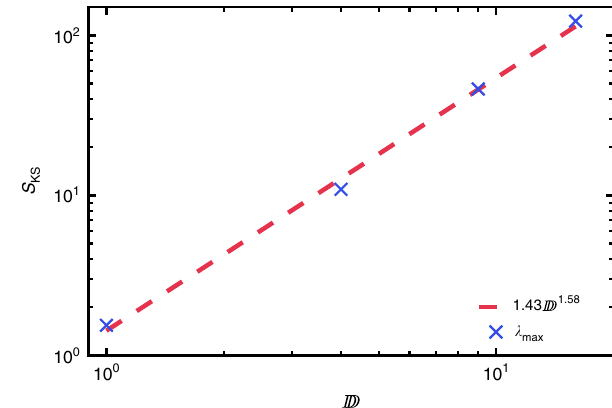
10 0 10 1 Fig. 8 Maximum Lyapunov exponent vs. thermo fi eld MPS bond order for the non-integrable system. The largest Lyapunov exponent for the Ising model with J = 1, h x = 0.5, h z = 1.0 obtained for an MPS representation of the thermo fi eld double. The exponent appears to be approaching zero like λ ¼ 1 : 09 D (cid:2) 0 : 373 max